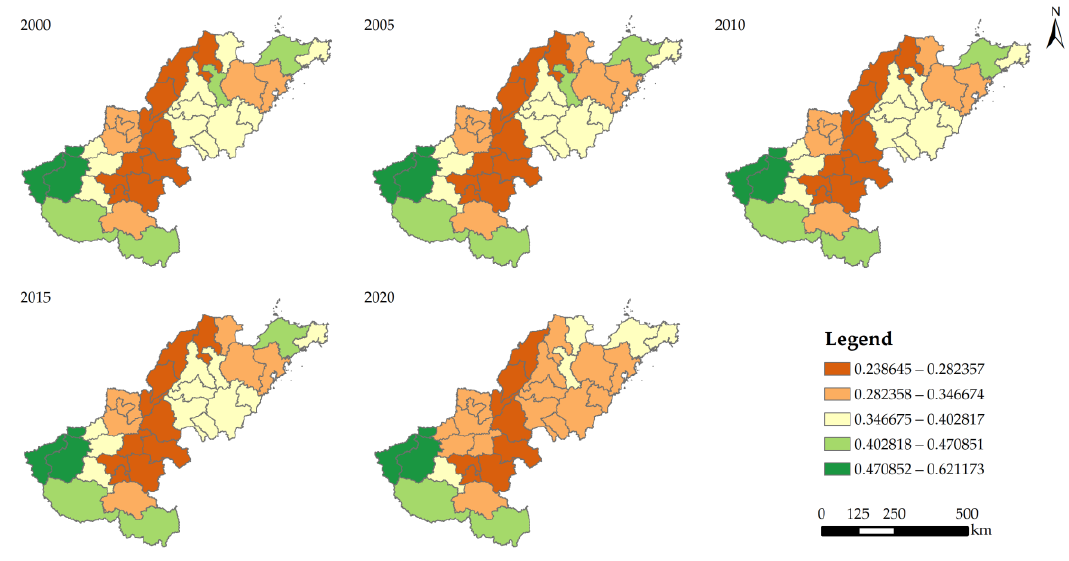
Figure 4. Habitat quality of each city in the Lower Yellow River from 2000 to 2020.